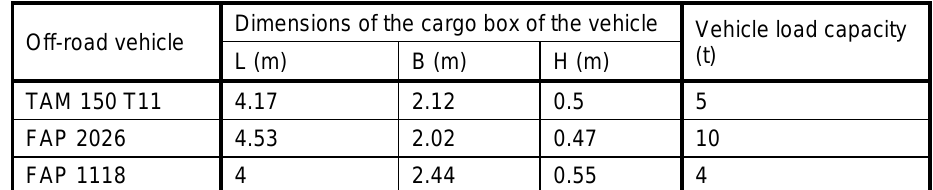
Table 6 – Basic data about vehicles that are entered into Cube IQ Таблица 6 – Основные данные о транспортных средствах, которые вводятся в Cube IQ